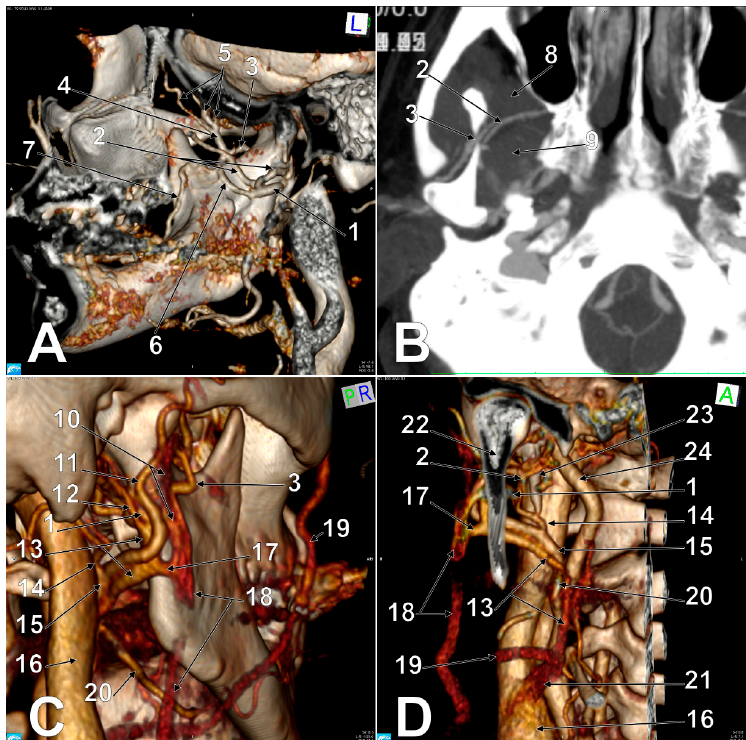
Figure 4. Details of the anatomic variations in Case #3. ( A ). Three-dimensional volume rendering, medial view of the right mandibular ramus. ( B ). Axial reconstructed slice through the right mandibular notch. ( C ). Three-dimensional volume rendering, postero-infero-lateral view of the right mandibular ramus. ( D ). Three-dimensional volume rendering, anterior view of Launay’s vein. 1. Maxillary vein; 2. maxillary artery; 3. extracondylar vein; 4. deep temporal venous trunk; 5. deep temporal veins; 6. communicating vein between the extracondylar and maxillary veins; 7. buccal vein; 8. temporal muscle; 9. lateral pterygoid muscle; 10. superficial temporal vein; 11. superficial temporal artery; 12. retrocondylar vein; 13. Launay’s external carotid vein; 14. occipitoauriaular trunk; 15. external carotid artery; 16. internal jugular vein; 17. anastomosis of the external carotid and external jugular veins; 18. external jugular vein; 19. proper facial vein; 20. facial artery; 21. common facial vein; 22. neck of mandible; 23. styloid process; 24. internal carotid artery.